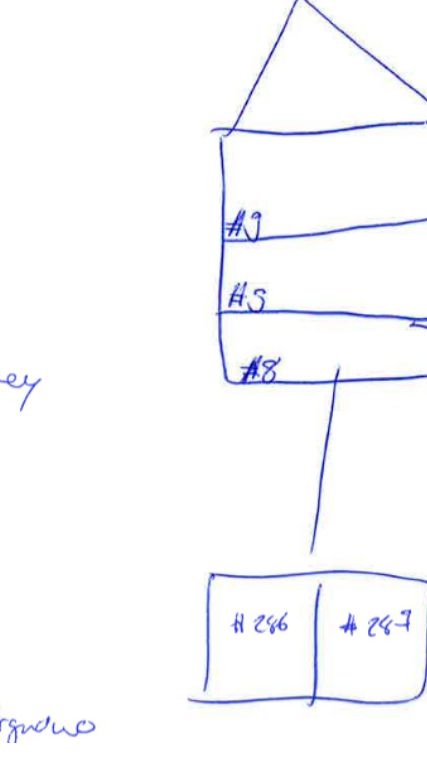
Figure 4. Example for a code interpretation question—building hierarchy.